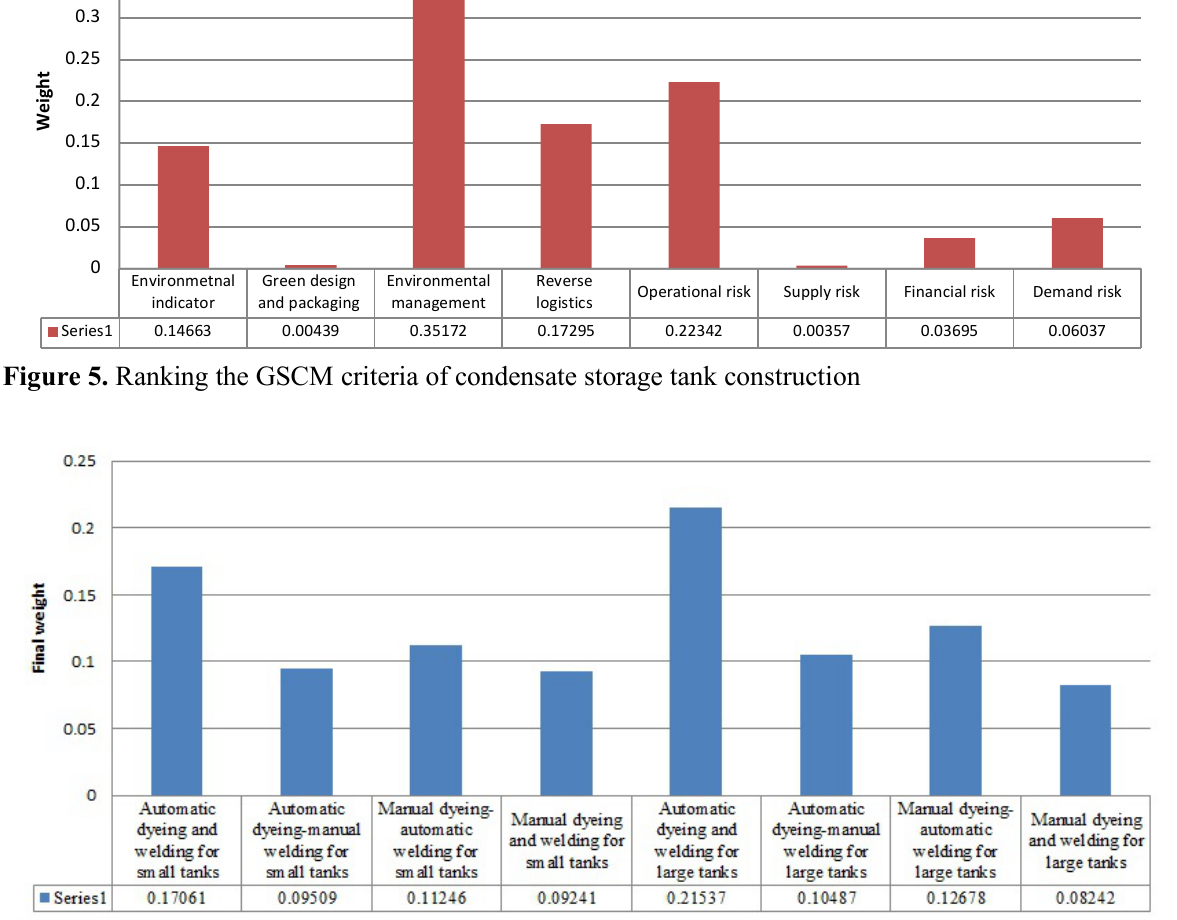
Figure 6. Final weight of the options for welding and dyeing of condensate storage